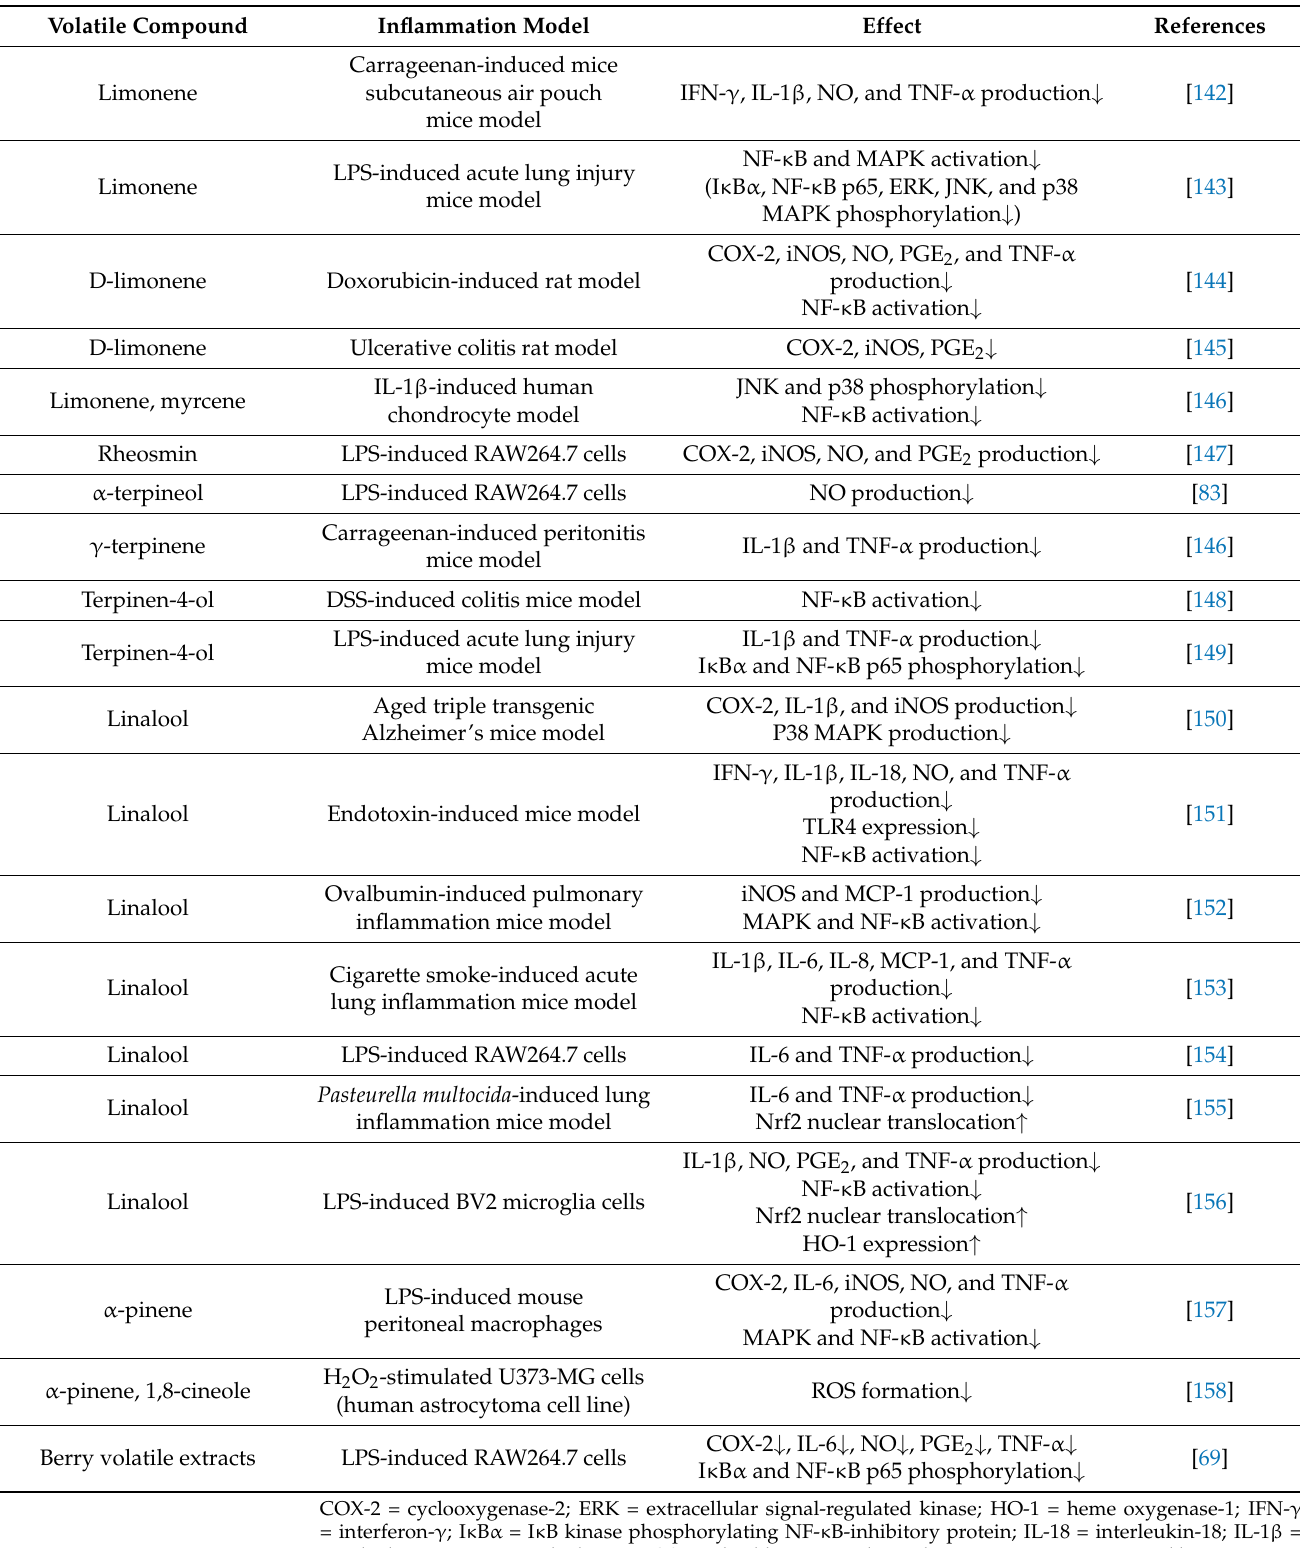
Table 2. The effect of volatile compounds rich in berries on inflammation